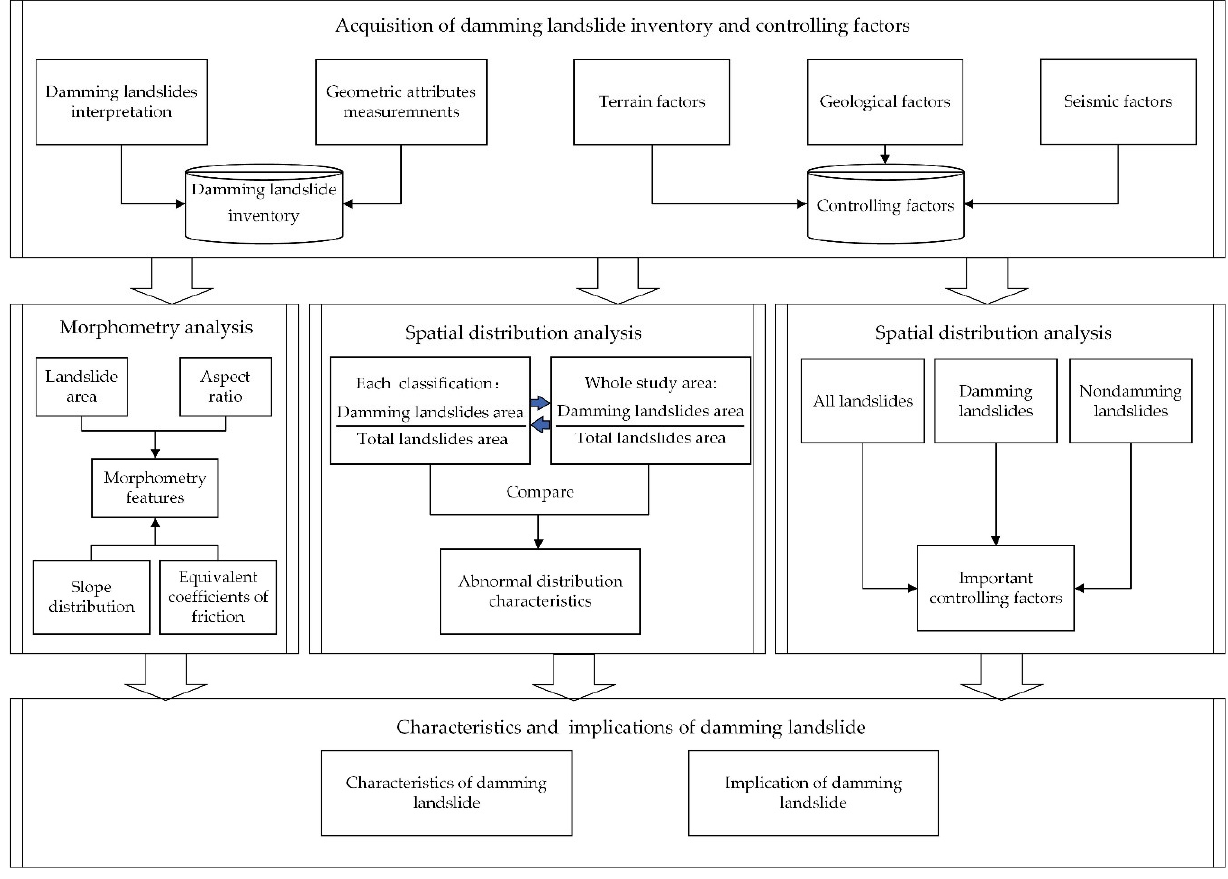
Figure 2. Procedural flow chart of this study.